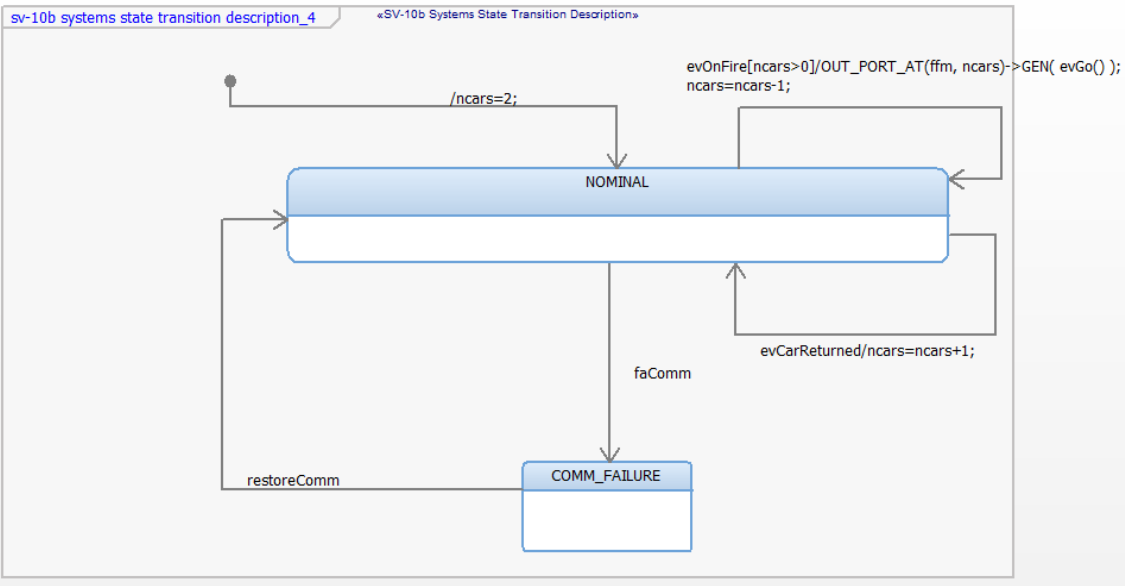
Figure 7. Behavior specification modeled in state machines using an SV ‐ 10b diagram for the fire station CS.